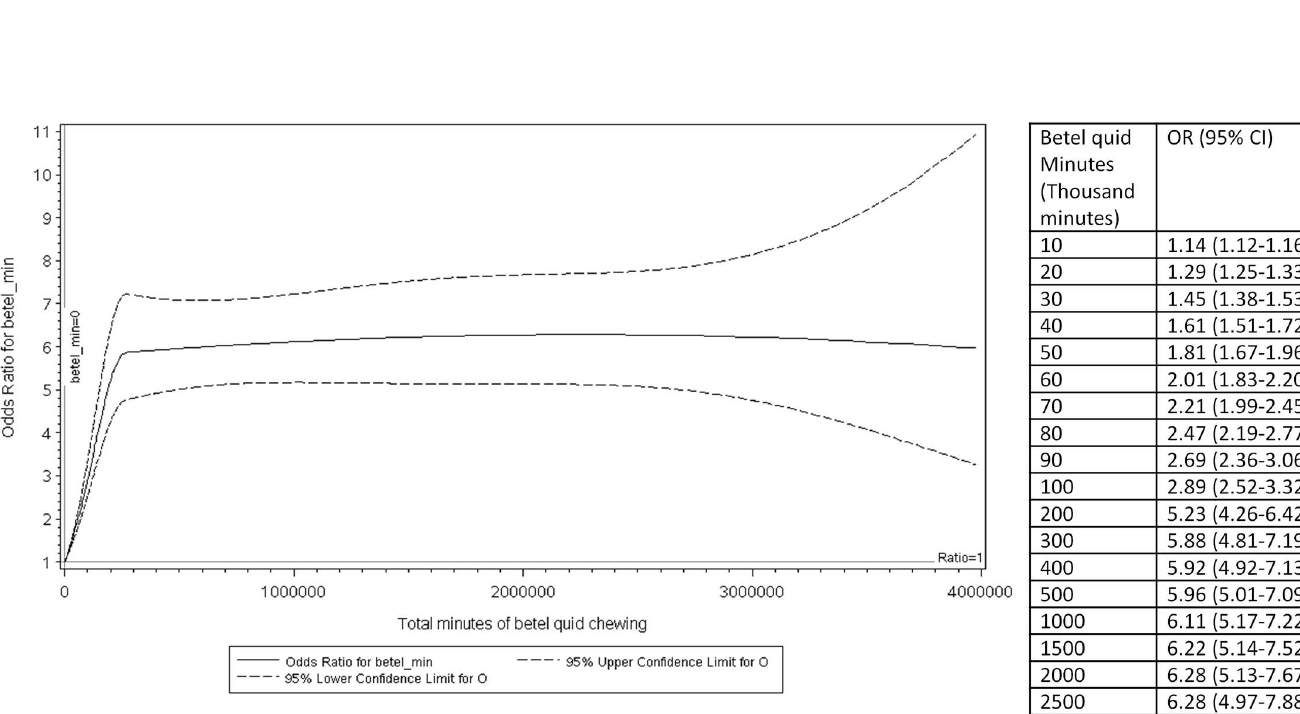
Fig 2. The association between total minute of betel quid chewing and risk of head and neck cancer. This figure shows the non-linearrelationship between total minute of betel quid chewingand risk of head and neck cancer. The middle solid line represents the odds ratios, the upper dashed line represents the 95% upper confidence intervals, and the lower dashed line represents the 95% lower confidence